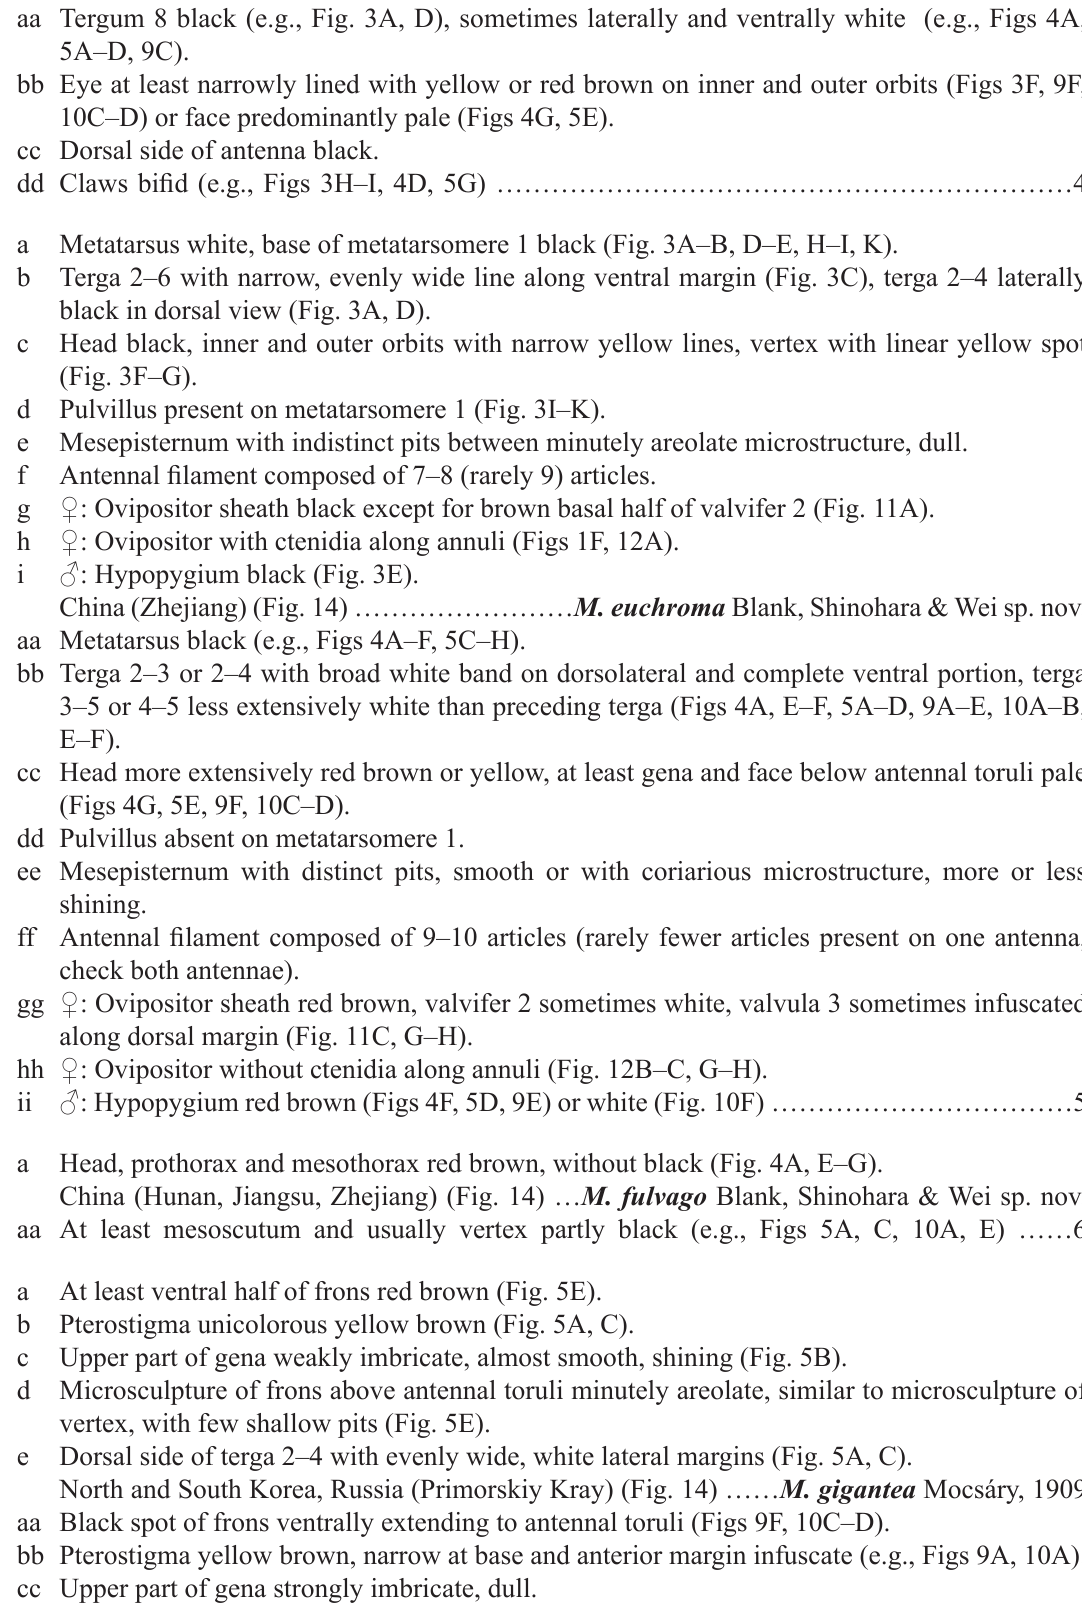
At least ventral half of frons red brown (Fig. 5E). Pterostigma unicolorous yellow brown (Fig. 5A, C). Upper part of gena weakly imbricate, almost smooth, shining (Fig. 5B). Microsculpture of frons above antennal toruli minutely areolate, similar to microsculpture of vertex, with few shallow pits (Fig. 5E). Dorsal side of terga 2–4 with evenly wide, white lateral margins (Fig. 5A, C). North and South Korea, Russia (Primorskiy Kray) (Fig. 14) …… M. gigantea Mocsáry, 1909 – Black spot of frons ventrally extending to antennal toruli (Figs 9F, 10C–D). Pterostigma yellow brown, narrow at base and anterior margin infuscate (e.g., Figs 9A, 10A). Upper part of gena strongly imbricate,